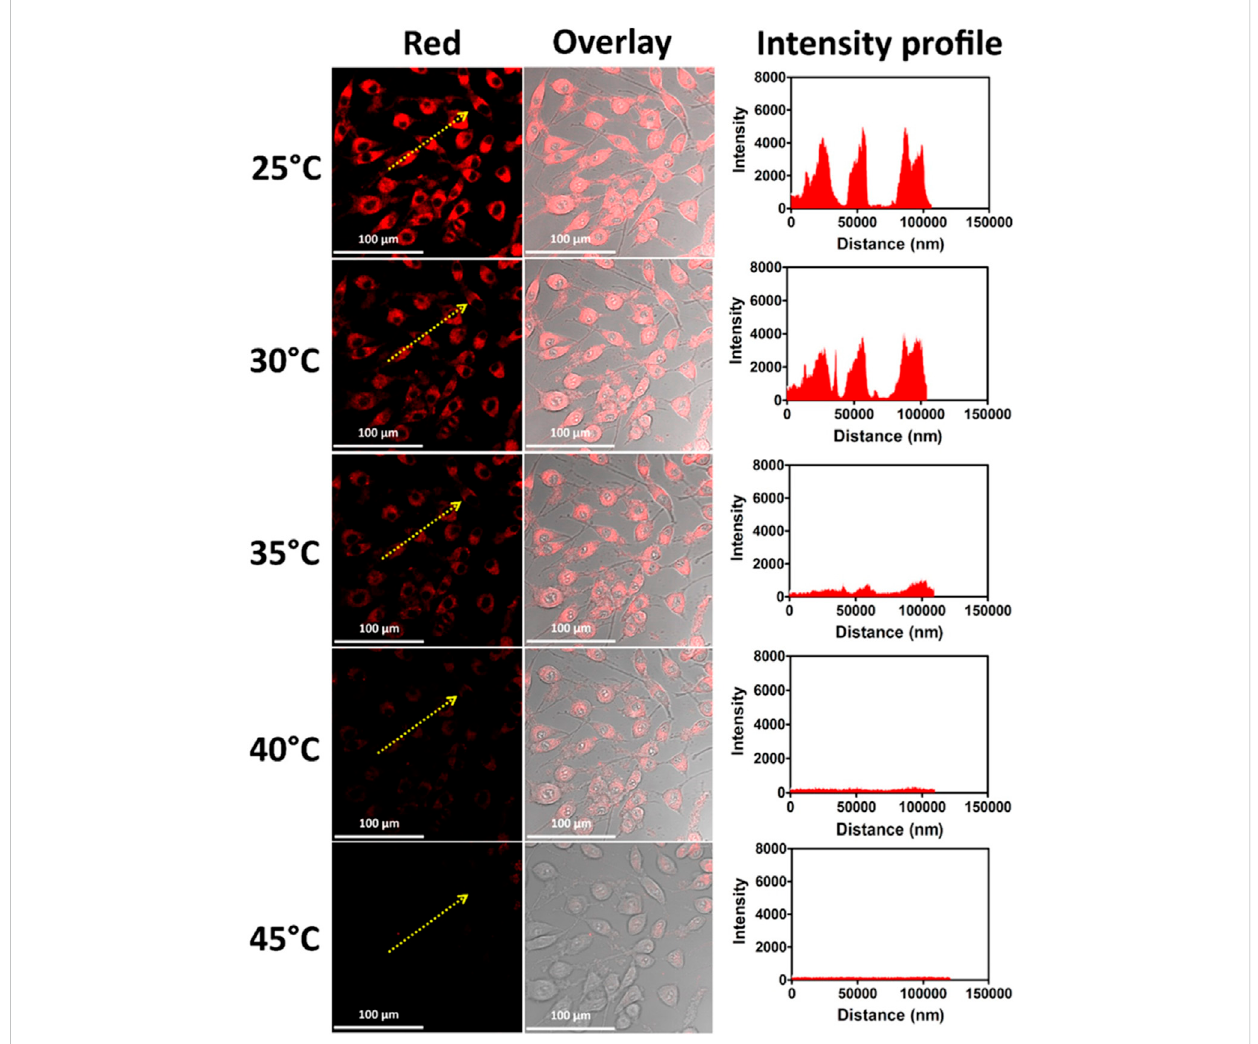
FIGURE 8 L929 cells with 0.1 mg/mL mGQDs for intracellular temperature sensing. Using CLSM ’ s temperature controller, a typical area was heated to 25 to 45 ° C (Kumawat et al., 2017).